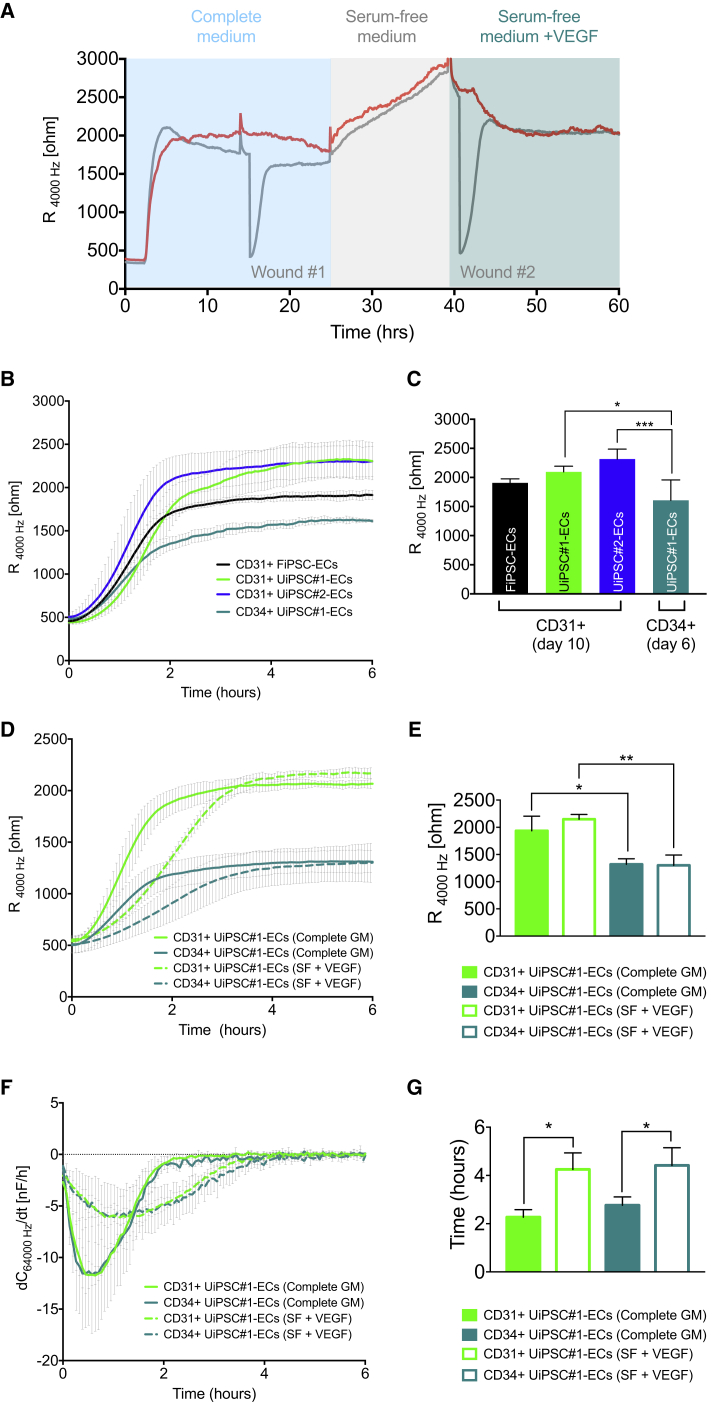
Comparative Assessment of Barrier Function and Real-Time Migration of Primary and hiPSC-ECs(A) Schematic illustration of ECIS barrier function assessment and real-time migration of hiPSC-ECs.(B) Representative absolute resistance of the EC monolayer in complete EC growth medium is shown. Error bars are shown as ±SD of three to four independent wells from representative biological experiments.(C) Quantification of absolute resistance values at 4,000 Hz in complete EC growth medium. Values are presented as average means from a minimum of three independent biological experiments. Error bars are shown as ±SD of three independent biological experiments. ∗p < 0.01, ∗∗∗p < 0.001.(D) Mean absolute resistance from of the EC monolayer in complete EC growth medium or serum-free medium supplemented with VEGF (75 ng/mL) is shown. Error bars are shown as ±SD of average values from three independent biological experiments.(E) Quantification of absolute resistance at 4,000 Hz of the EC monolayer in complete EC growth medium or serum-free medium supplemented with VEGF (75 ng/mL). Error bars are shown as ±SD of three independent biological experiments. ∗p < 0.05, ∗∗p < 0.001.(F) Mean speed of migration (dC/dt) determined as a change in capacitance at 64,000 Hz over the time after electric wound healing in complete EC growth medium or serum-free medium supplemented with VEGF (75 ng/mL). Error bars are shown as ±SD of average values from three independent biological experiments.(G) Quantification of migration rates determined as a time upon closing the wound (dC/dt>(−0.1 nF/hr)) of hiPSC-ECs in real-time wound healing assay in EC monolayer in complete EC growth medium or serum-free medium supplemented with VEGF (75 ng/mL). Error bars are shown as ±SD of three independent biological experiments. ∗p < 0.05.